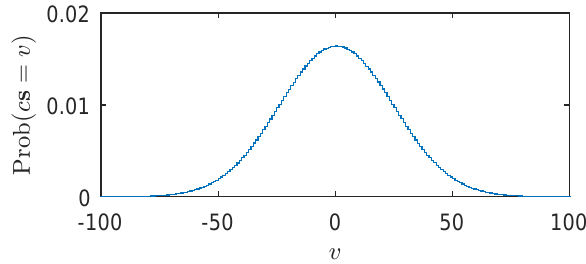
Figure 2: Coefficient-wise probability distribution of c